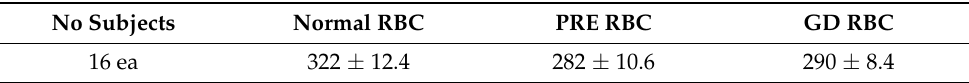
Table 1. Red Blood Cell Intracellular Free Ionized Mg ( µ M) Depressed Taken from Preeclamptic (PRE) and Gestational Diabetic (GD) Pregnant Women at Term.